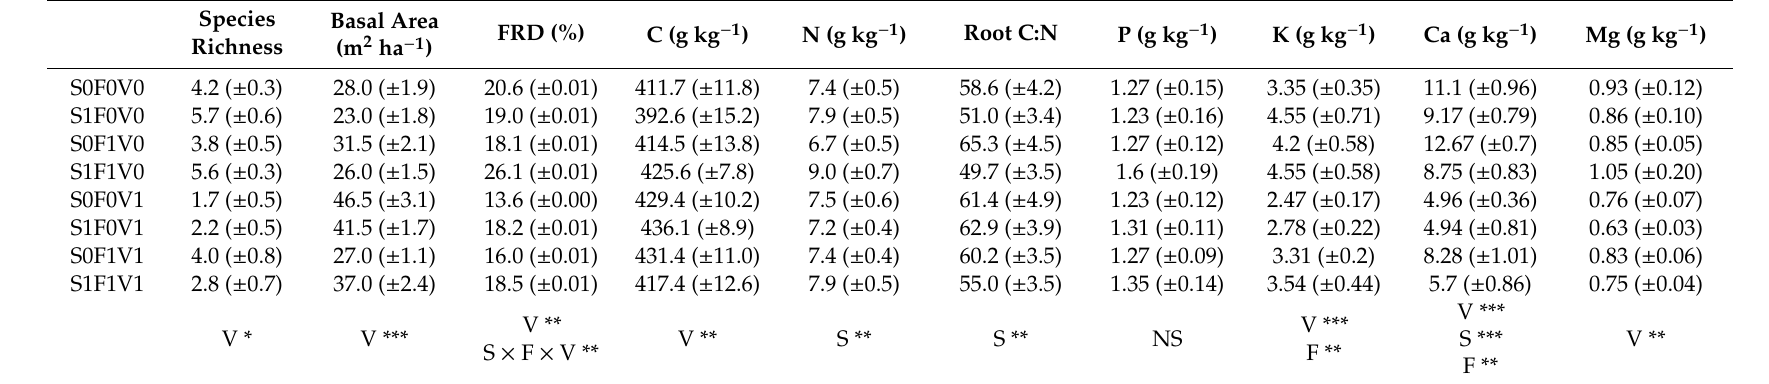
Table 1. Impact of silvicultural treatments on overstory volume (Basal area), understory vegetation diversity (Species richness), fine root decomposition (FRD) and fine root C and macronutrients, 27 years after establishment of a white pine plantation ( n = 96). S = scarification, F = fertilization, V = vegetation control, 0 = no treatment, 1 = application of treatment. Values are mean and standard errors are presented in